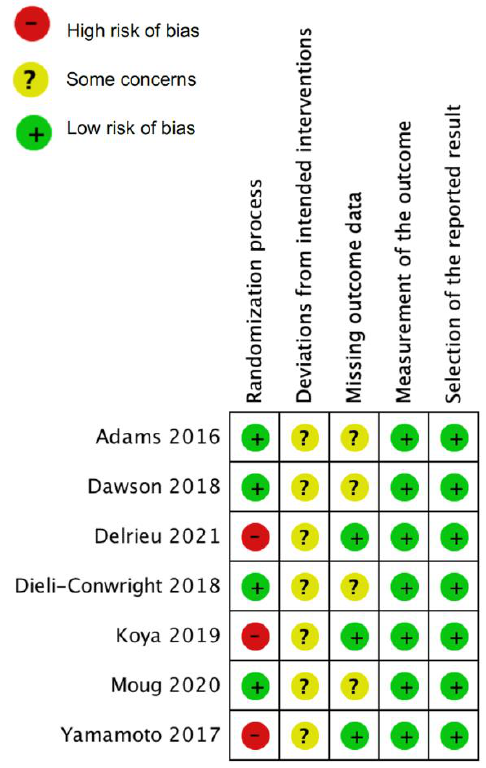
Figure 2. Risk of bias of included studies. Outcome assessed was: SMI for Adams et al. [23], Yamamoto et al. [24] and Koya et al. [27]; ASMI for Dawson et al. [25] and Dieli-Conwright et al. [26]; TPI for Moug et al. [28]; LBM for Delrieu et al. [29].